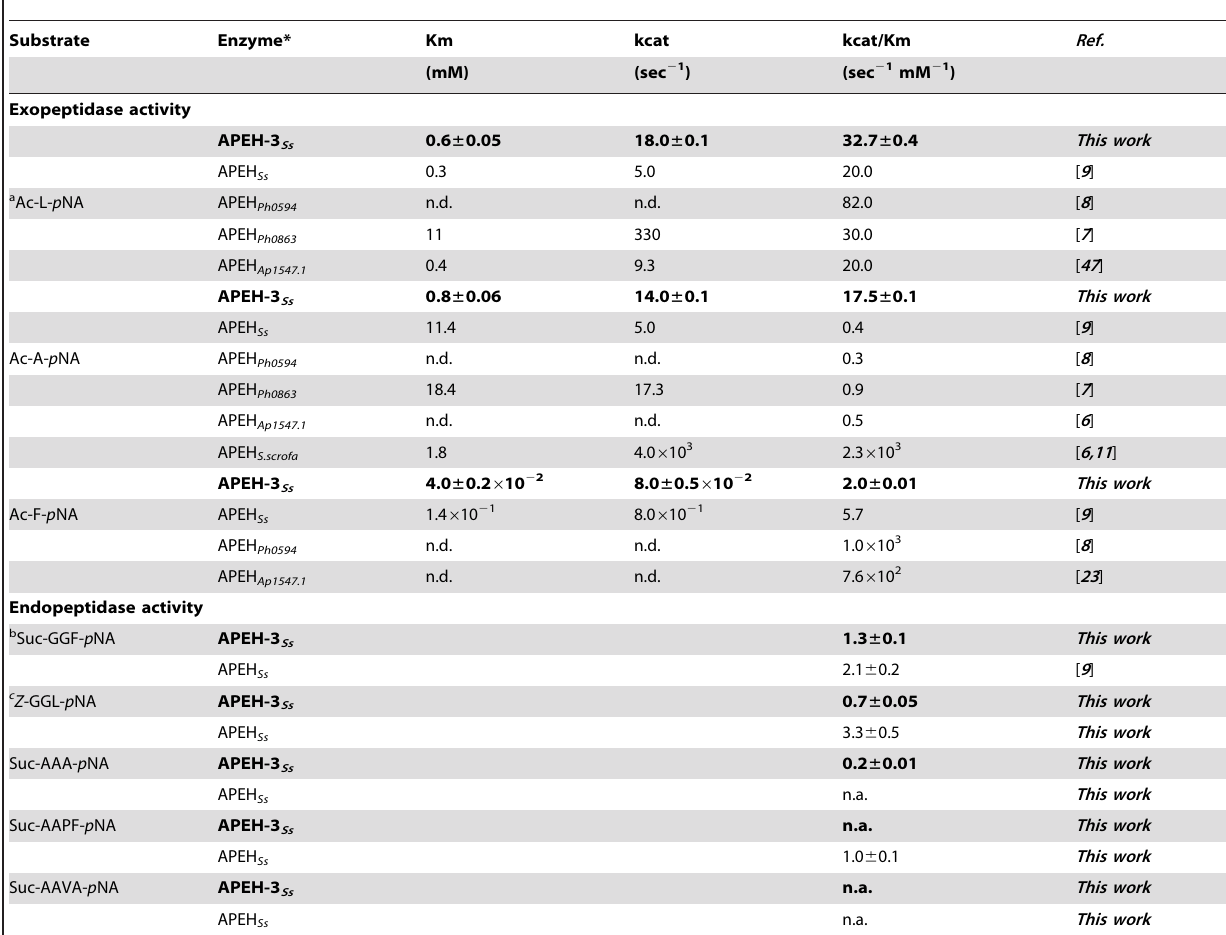
Table 2. Kinetics parameters of APEH-3 Ss compared with those of APEH from archaeal and mammalian sources.